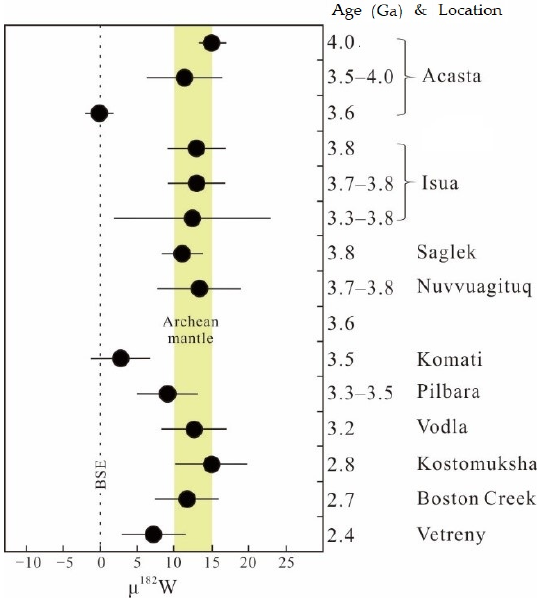
Figure 6. ε 182 W values for Archean rocks (following from [59]). The yellow and gray shaded areas represent the ε 182 W values of the Archean mantle and the BSM, respectively.